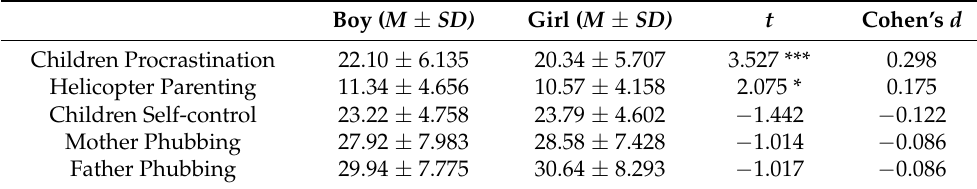
Table 3. Means, standard deviations, and correlations of the variables.